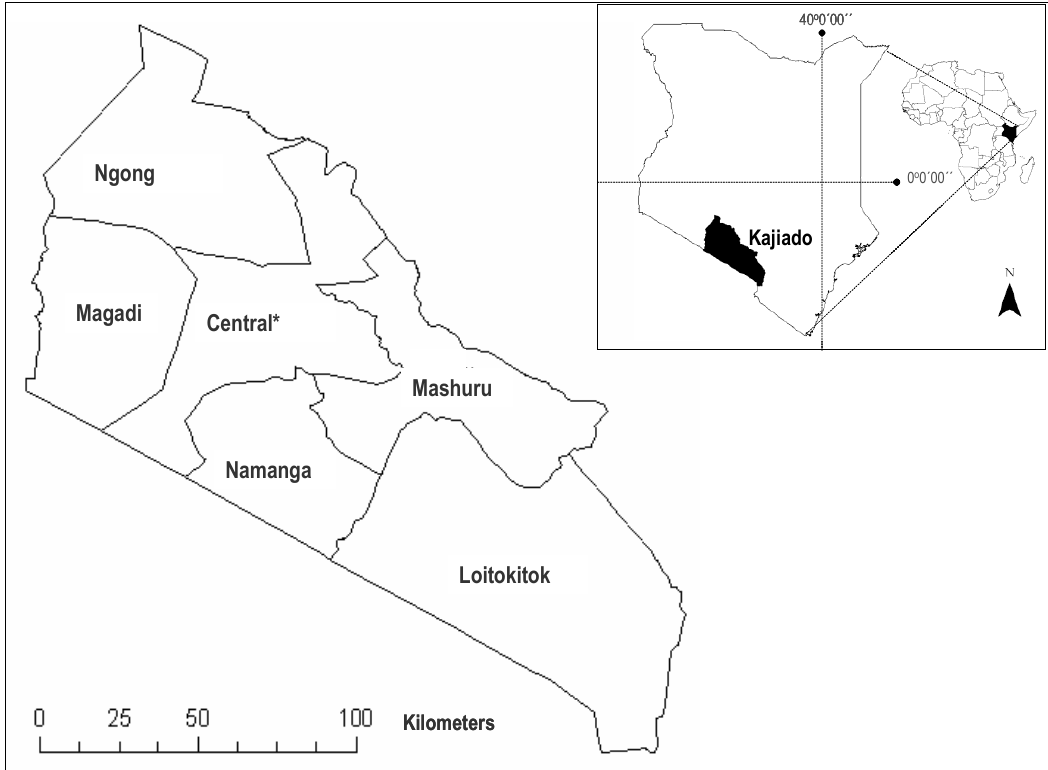
Figure 1. Kajiado District, Kenya, showing six the administrative divisions. * Central Division has since been sub-divided. Inset: Map of Kenya and Africa showing the location of Kajiado in the context of the broader region.